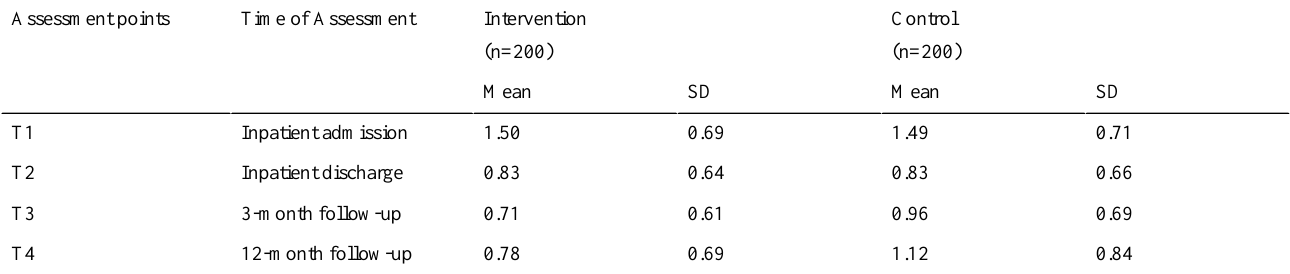
Table 1. Descriptives for primary trial main outcome, psychopathological symptom severity as measured by the general psychopathological symptom severity subscale of the HEALTH-49 questionnaire.